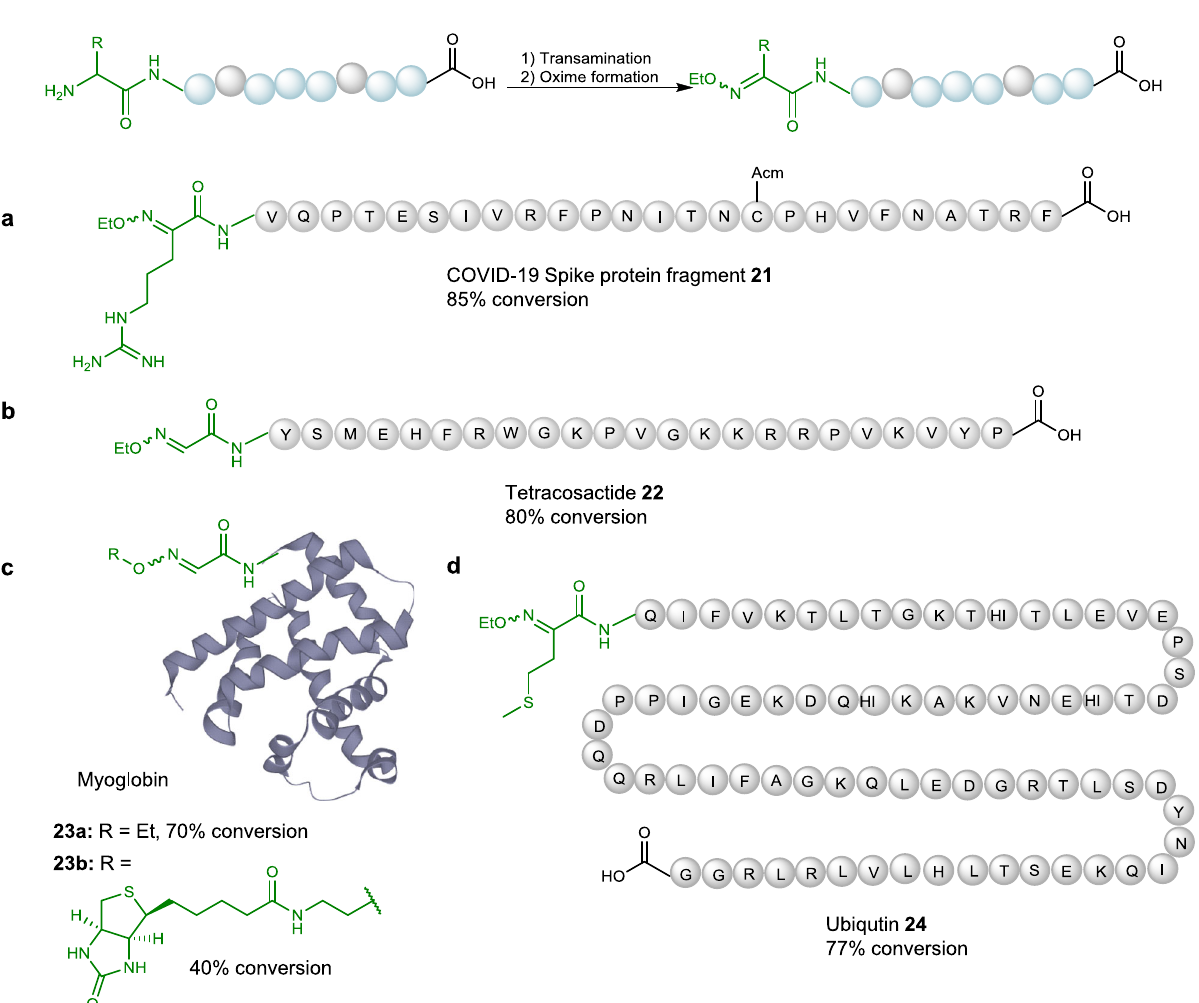
Fig. 4 Site selective peptide modi fi cation via quinone-mediated transamination reaction. a Reaction conditions for COVID-19 spike protein fragment 21 : (1) Transamination: 2 M Gn·HCl, Ox1 (10 mM, sat.), 200 mM Na 2 HPO 4 , pH 6.5, 6 h, 25 °C; (2) Oxime formation: EtONH 2 ·HCl (100 mM), pH 4.0, 3 h, 25 °C. b Reaction conditions for tetracosactide 22 : (1) Transamination: Ox1 (10 mM, sat.), 200 mM Na 2 HPO 4 , pH 6.5, 3 h, 25 °C; (2) Oxime formation: EtONH 2 ·HCl (100 mM), pH 4.0, 3 h, 25 °C; c Reaction conditions for myoglobin 23a-b : (1) Transamination: Ox1 (10 mM, sat.), 200 mM Na 2 HPO 4 , pH 4.0, 5 h, 25 °C; (2) Oxime formation for 23a : EtONH 2 ·HCl (100 mM), pH 4.0, 3 h, 25 °C; oxime formation for 23b : extraction with EtOAc (2 ×1.0 mL), then biotinylated tag S5 (100 mM), pH 6.5, 16 h, 25 °C. d Reaction conditions for ubiquitin 24 : (1) Transamination: 2 M Gn·HCl, Ox1 (10 mM, sat.), 200